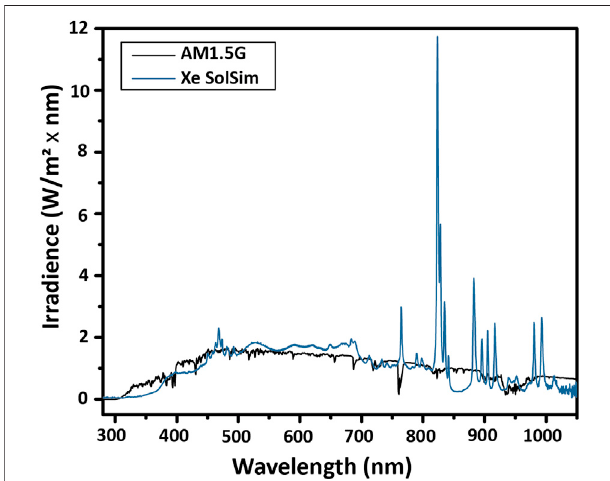
FIGURE 8 | Spectral mismatch. The spectral shape of the lamp (Xe SolSim) differs from that of the reference spectrum, particularly due to the strong emission lines of Xe lamps around 800 nm. For accurate calibration, either a band gap-matched, calibrated reference cell or a spectral mismatch calculation is